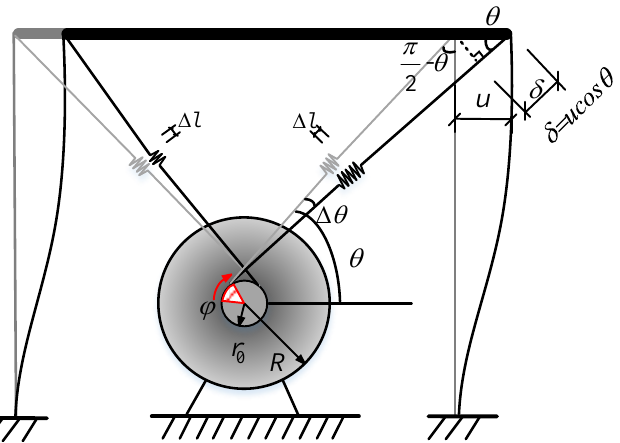
Figure 4. Transmission mechanism of cable-bracing inerter system.